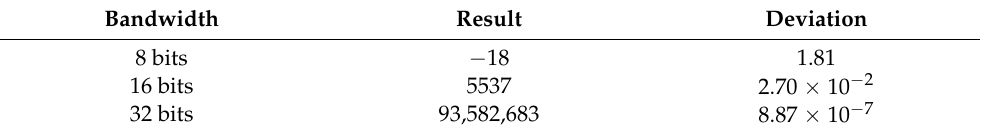
Table 4. Comparison of different bandwidth 1.484 rad cosine value generated by the RT technique.